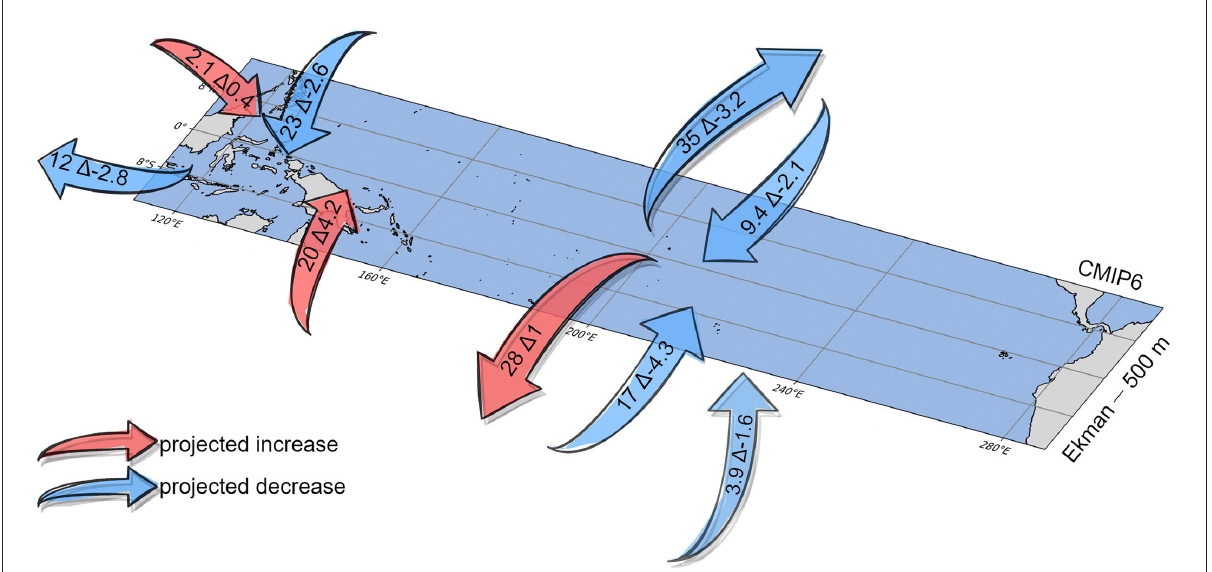
FIGURE4 CMIP6 multi-model mean interior and Ekman transport. Arrows indicate the direction of flow in the historical scenario and arrow colors indicate the sign of the projected changes. Transport values (in Sv) are given inside each arrow in the form: historical 1 projected change. The interior transport is calculated from the edge of the LLWBCs. The LLWBCs, ITF and sum of transport through the remaining straits are integrated between 0 and